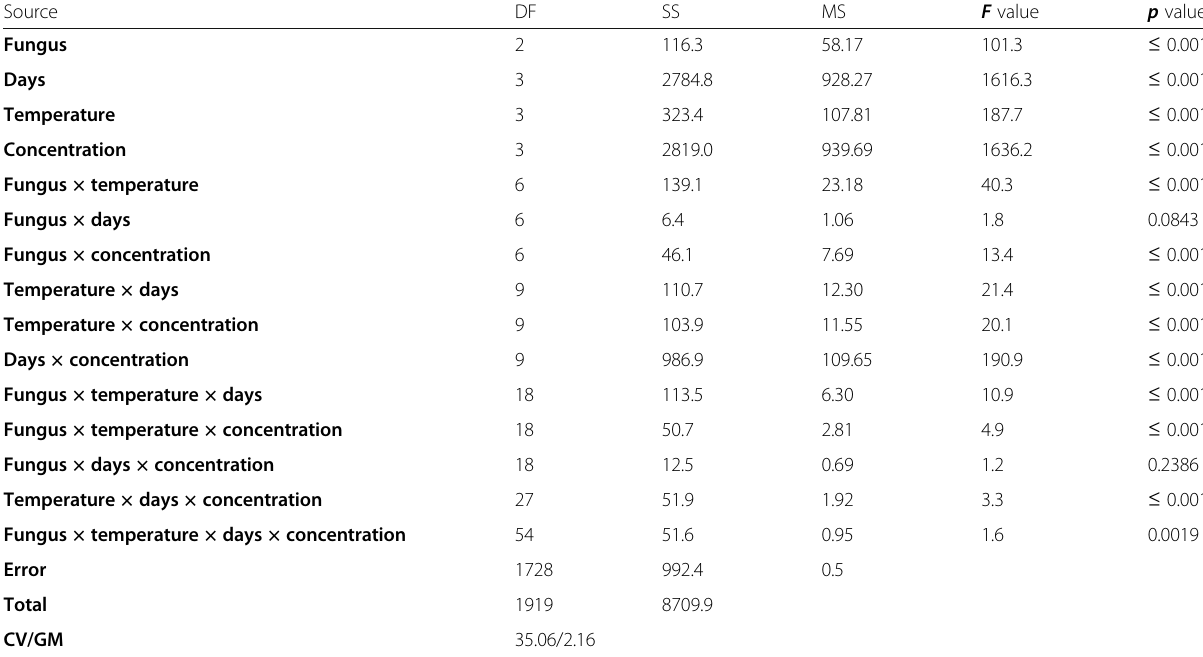
Table 2 Factorial analysis of variance of mortality of Bemisia tabaci bioassay with the conidia of two strains of Beauveria bassiana and one strain of Lecanicillium lecanii